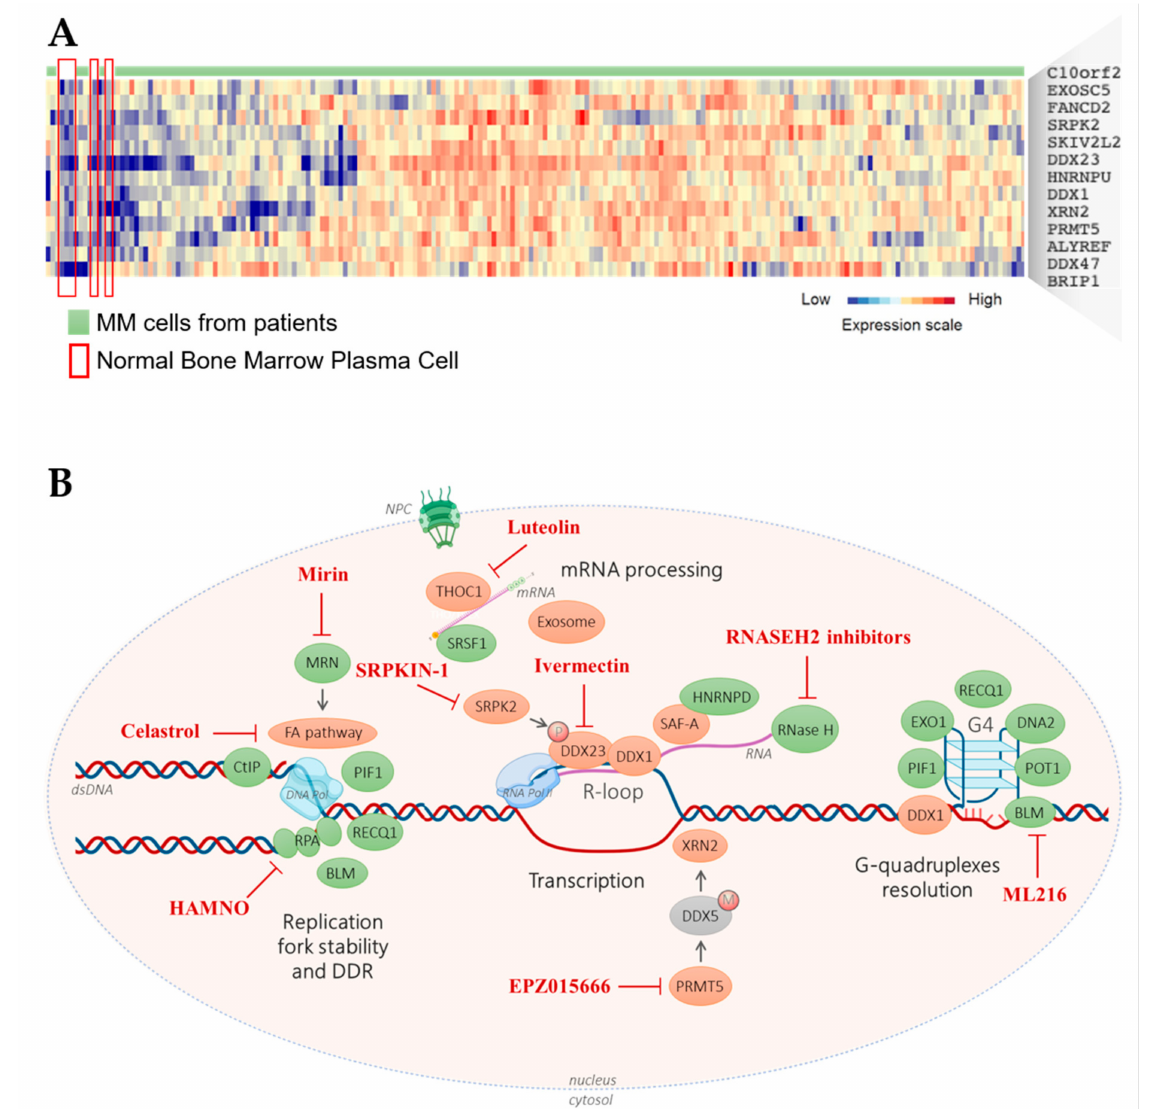
Figure 3. Gene expression profile of TRCs resolution genes in purified MM cells from patients. ( A ) Cluster analysis of TRCs gene expression in normal bone marrow plasma cells (BMPCs, n = 5) and purified MM cells from patient ( n = 206). ( B ) Potent roles of TRCs resolution factors in MM and their inhibitors. Cf legend in Figure 1B. Orange: genes overexpressed in MM